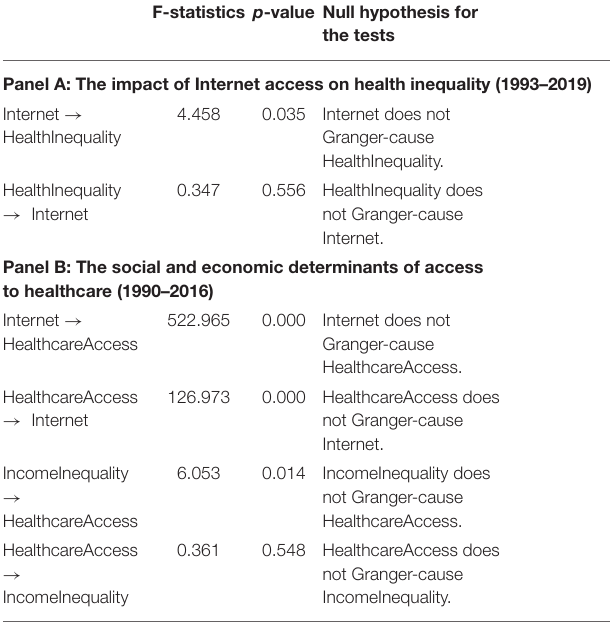
TABLE 5 | The social and economic determinants of access to healthcare (1990–2016).